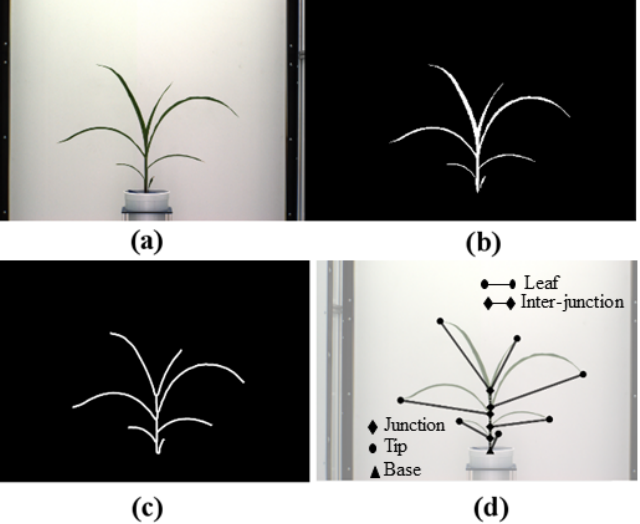
Figure 4. Illustration of the graph representation of a plant: ( a ) original image; ( b ) binary image; ( c ) skeleton; and ( d ) graph